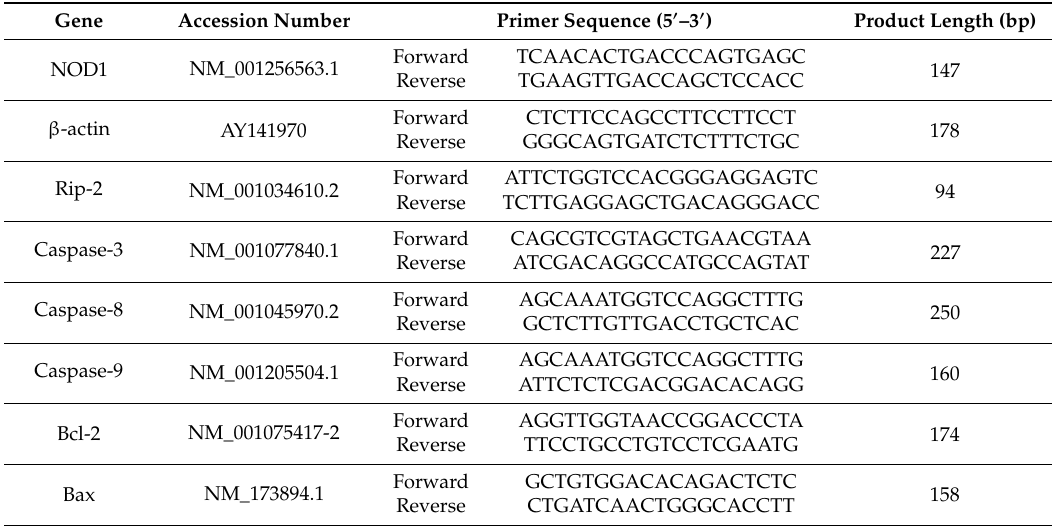
Table 1. List of primers and their sequence used for qRT-PCR in dairy